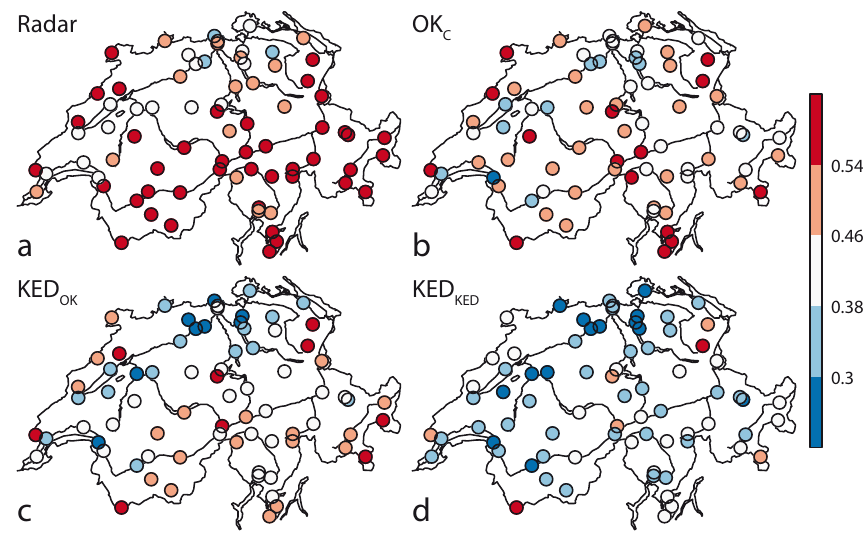
Fig. 12. RMSE ( mm 0 . 5 ) for extended evaluation in 2008 by gauge station. the gauge locations due to the fact that no nugget effect is taken into account by the correlograms used